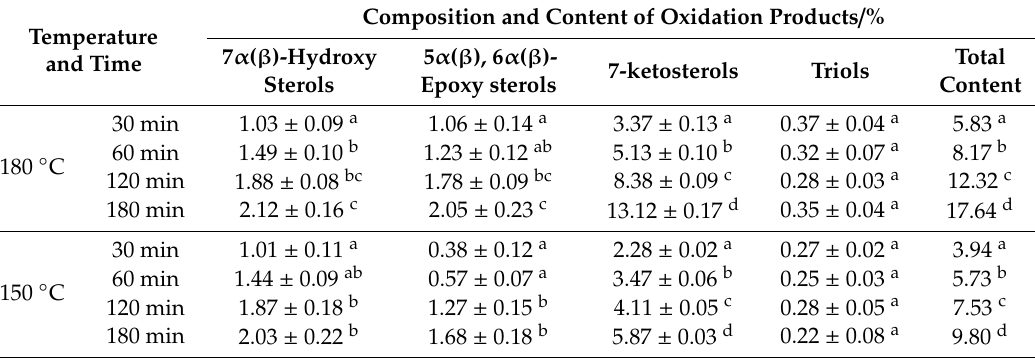
Table 4. The total content and composition of SGPs’ oxidation products in lard *.